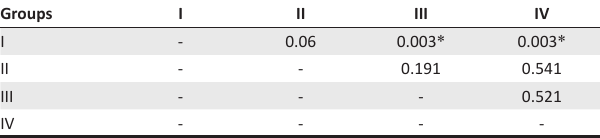
TABLE 1: Mann Whitney U test findings in Simple Pretend Play Free Play scenario. Groups